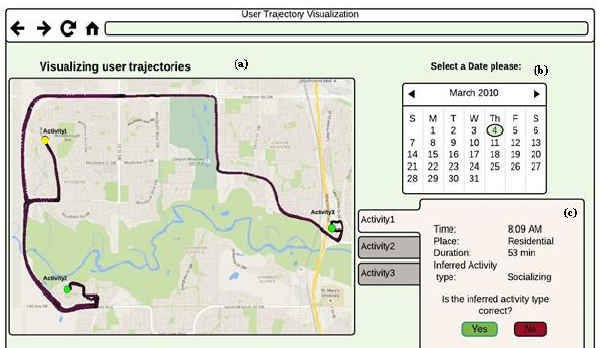
Figure 12. User interface to visualize user’s trajectories in order to get his/her